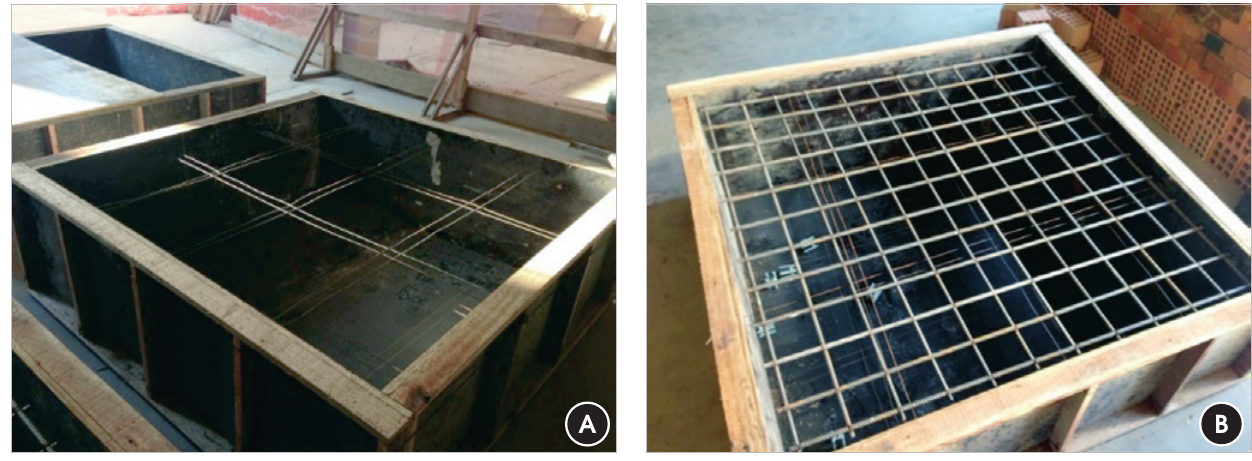
(a) wall without reinforcement (b) wall with reinforcement